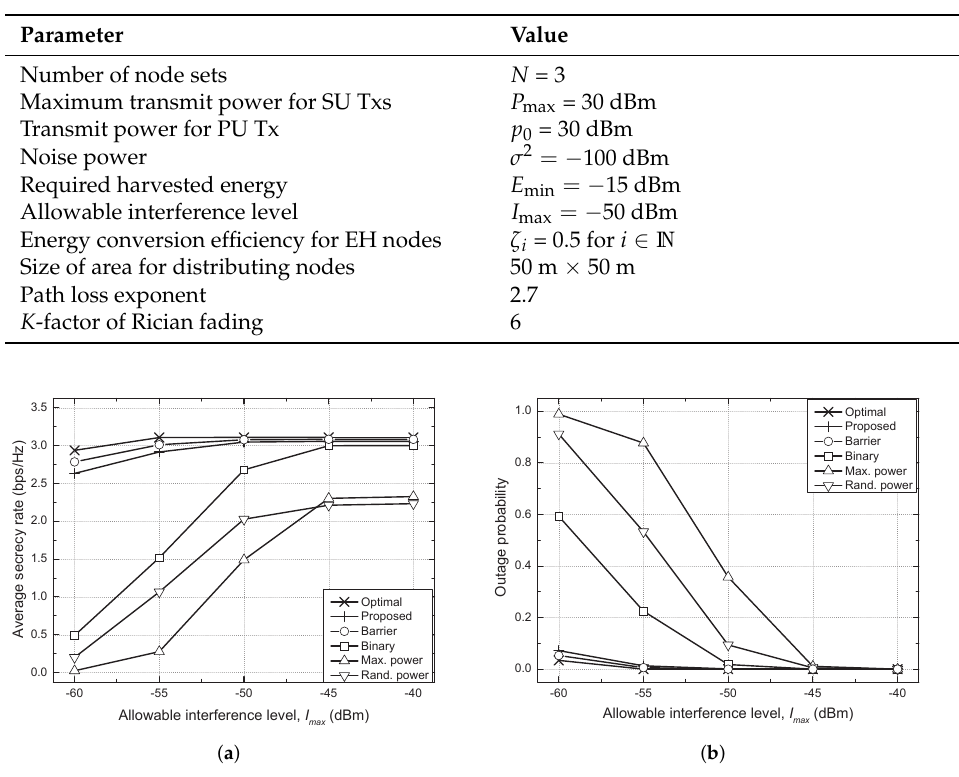
Table 1. Parameter Setup.